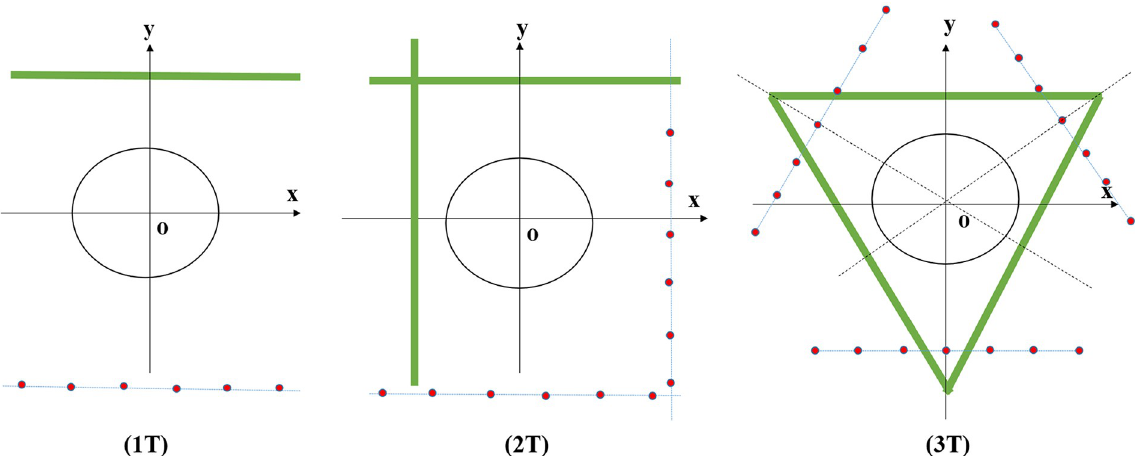
Fig 2. Different translational modes. The X-ray source is translated on the line where the red points located, and the corresponding flat panel detector is opposite translated on the green